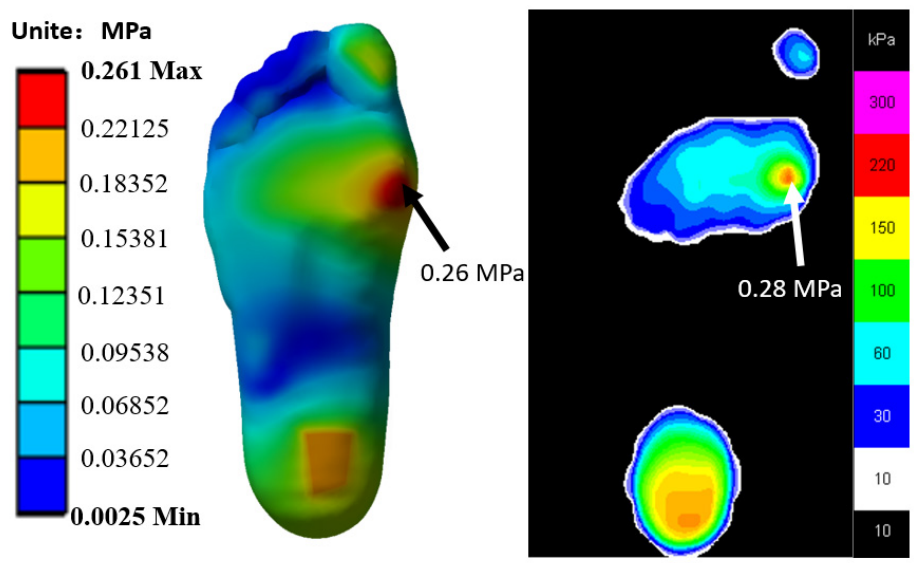
Figure 4. Comparison of the plantar pressure between computational prediction and experimental measurement in a balanced standing position.